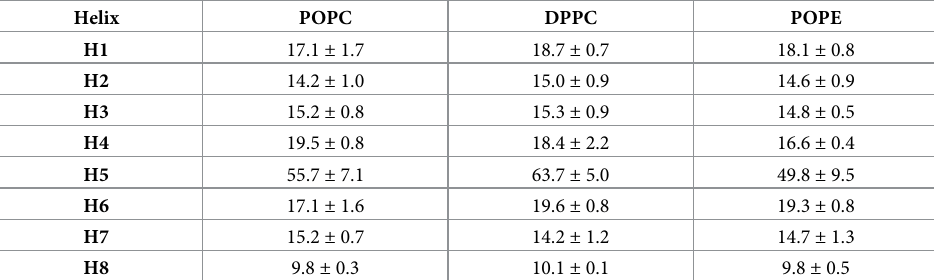
They are calculated using the Bendix plugin of VMD for POPC, DPPC, and POPE systems, as obtained from the 15 μ s CG MD runs at P = 1.01325 bar and T = 310